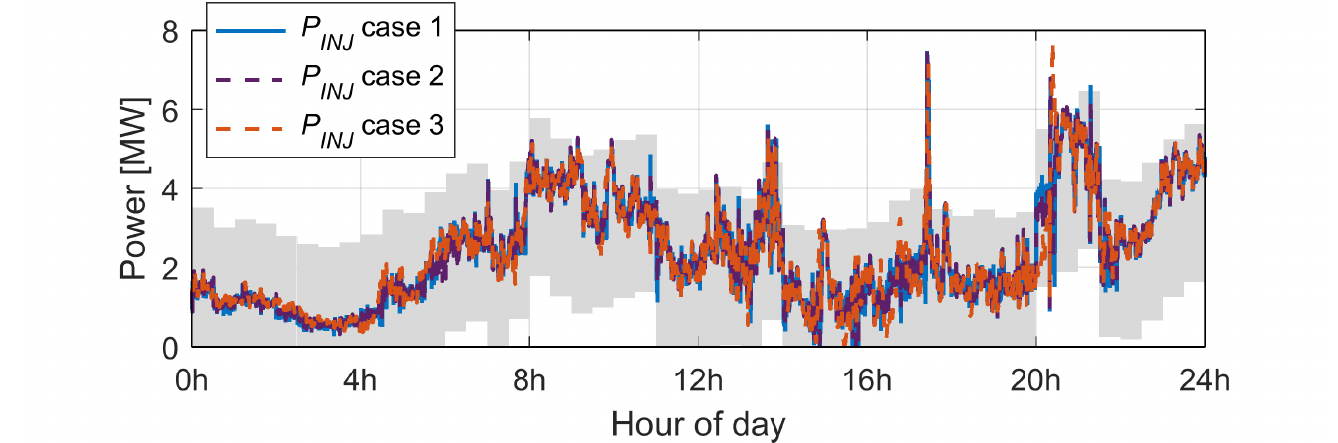
Figure 24. Scenario 1: Injected power and tolerated band/injection